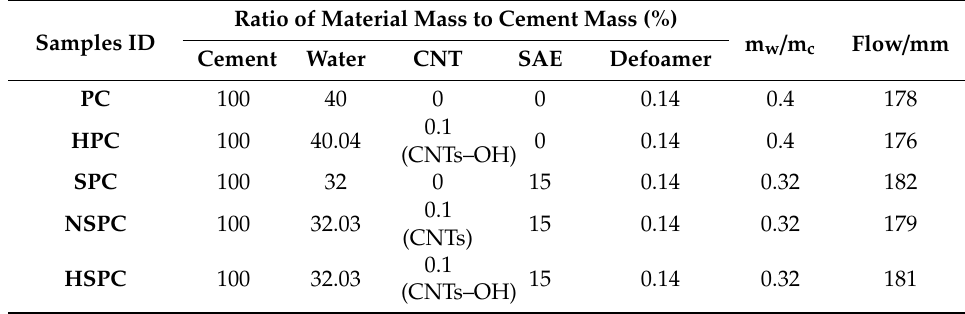
Table 4. Mix proportions of the